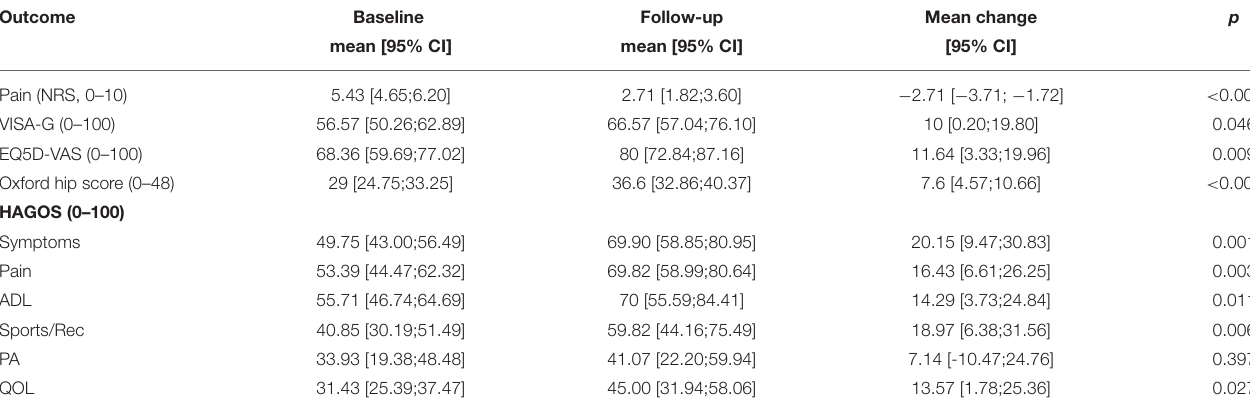
TABLE 2 | Patient-reported outcomes ( n = 14).